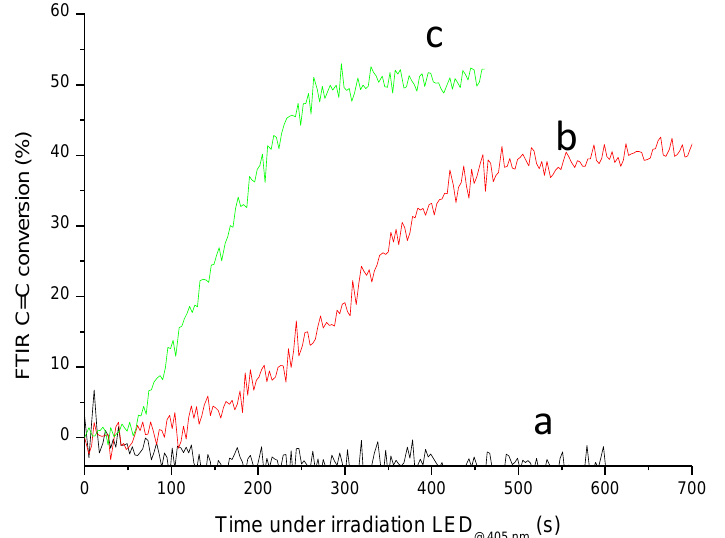
Irgacure 2959_commercial + NHCB(3) Irgacure 1173_OH + NHCB(3) Irgacure 1173_OMe + NHCB(3)